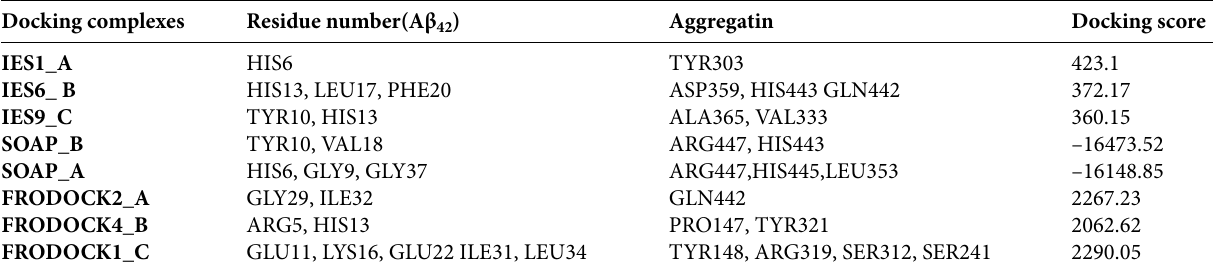
Table 2. Probable interface residues on each protein between the model of Aggregatin and Aβ 42 peptides. IES and FRODOCK2 score (higher is better), SOAP_PP score (lower is better).